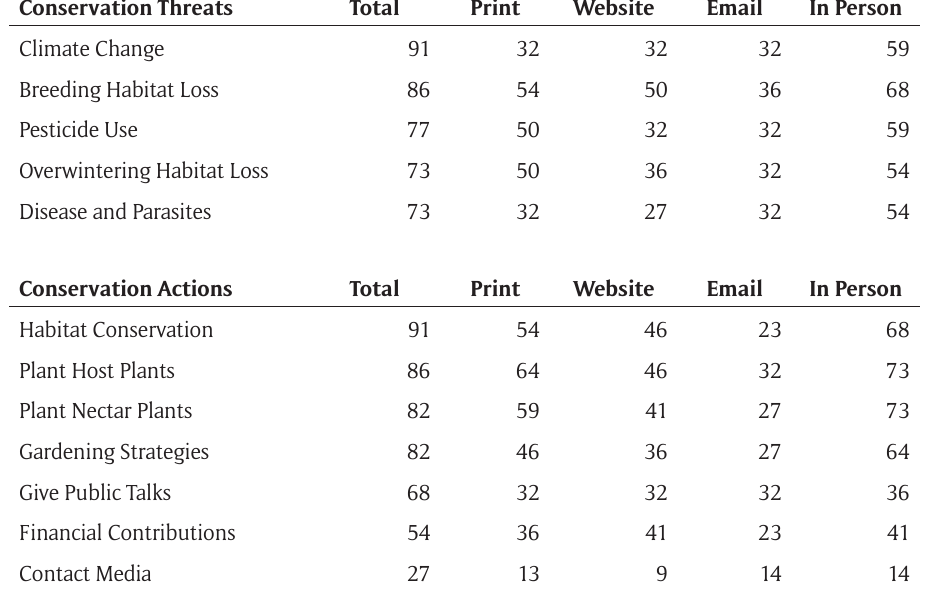
Table 1: Percentage of project leaders who report supplying their volunteers with information on conservation topics, by format and overall total, n = 22. Formats are not mutually exclusive.